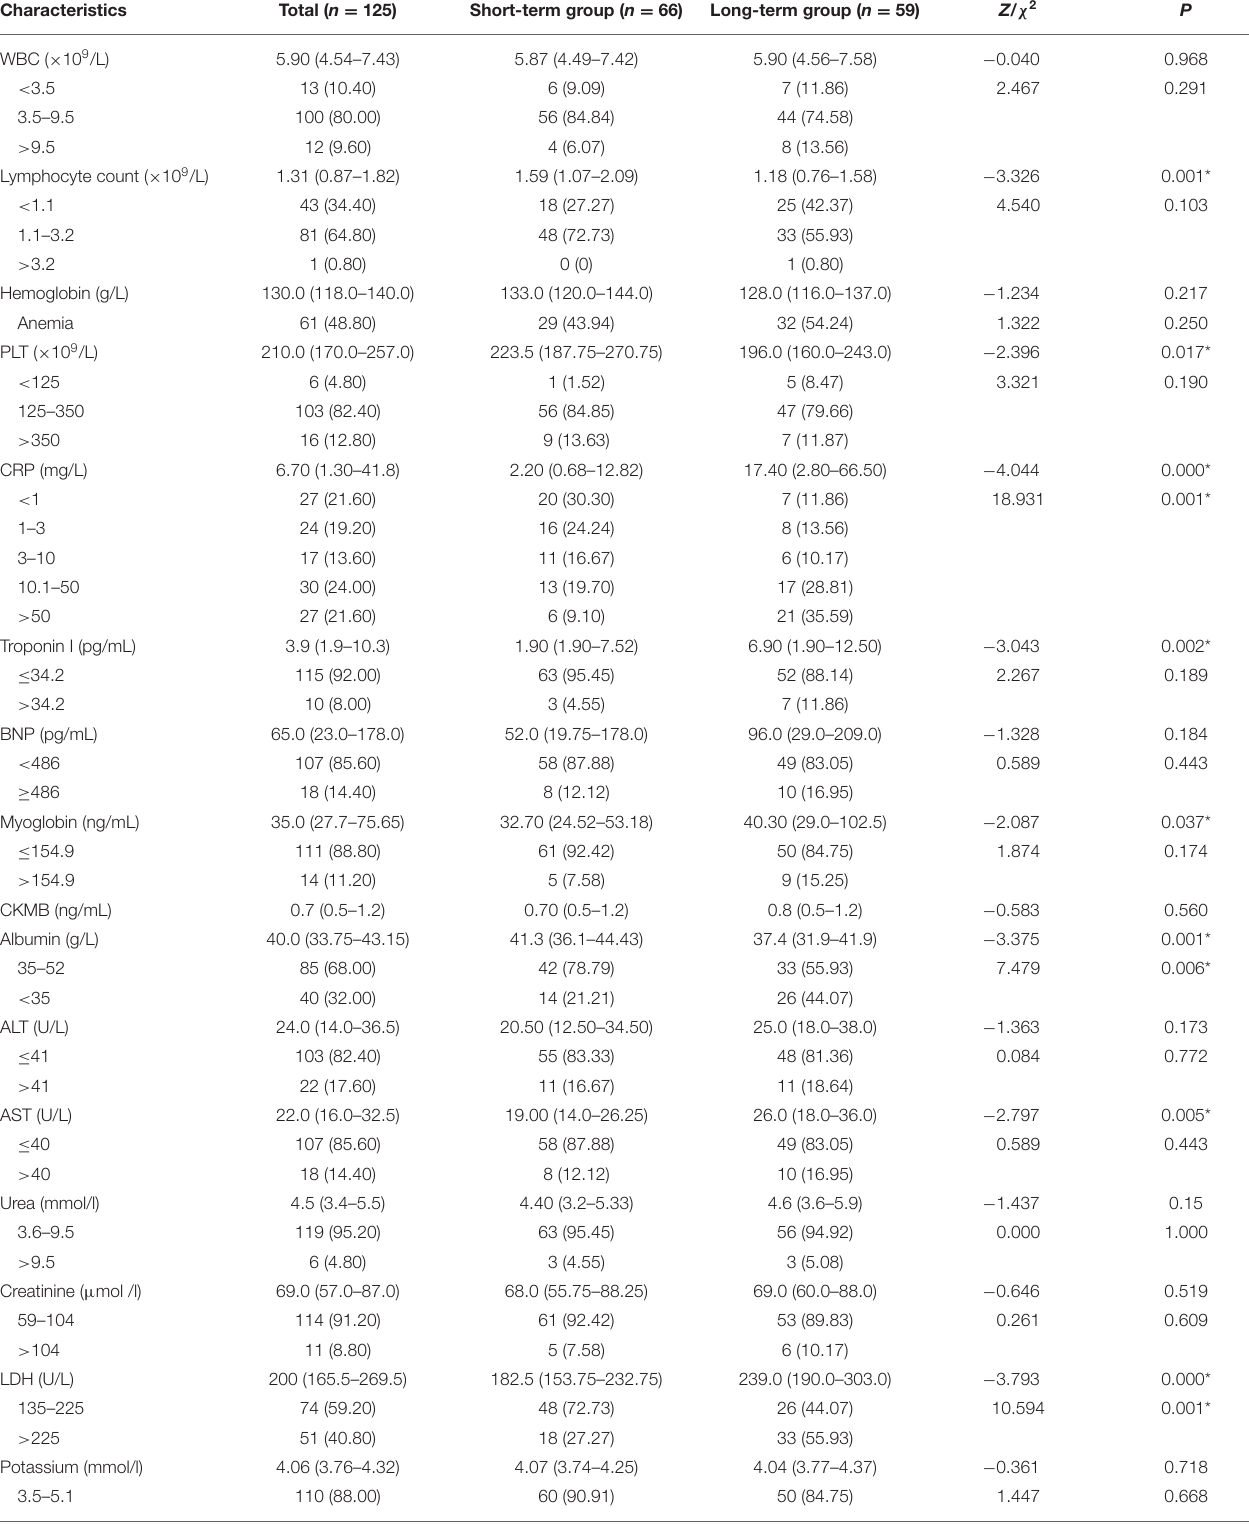
TABLE 2 | Comparisons of laboratory indices, radiographic findings, and treatments of 125 patients with COVID-19 between the two groups.